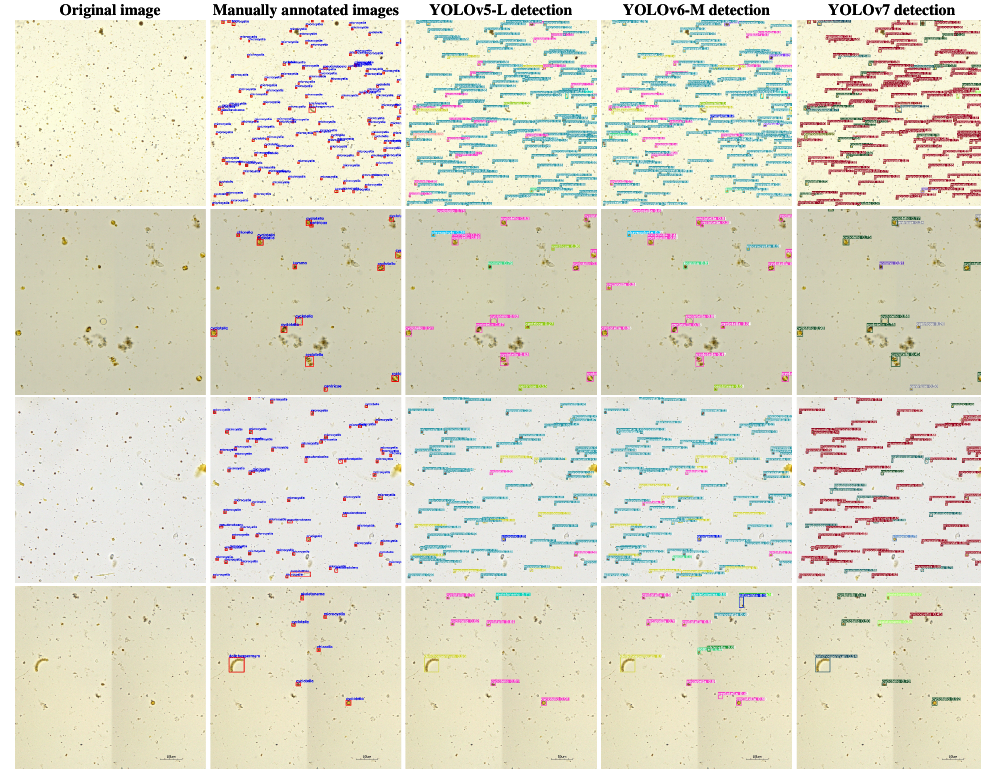
Figure 4. Schematic of four randomly selected images in the test set and the corresponding detection results. The four images in each row from left to right are the original image, the corresponding manually annotated image and the final detection results of YOLOv5-L, YOLOv6-M and